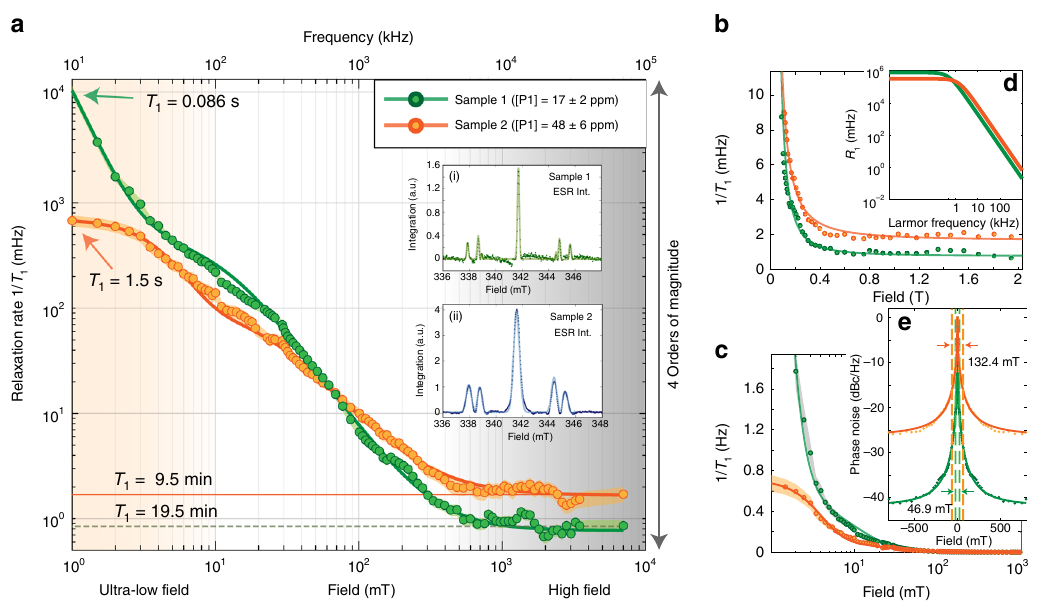
Fig. 3 Hyperpolarized relaxometry at natural abundance 13 C relaxation rate over four decades of fi eld 1 mT-7 T (lower axis) for Samples 1 and 2, probing spin- fl ipping spectral density from 10 kHz to 75 MHz (upper axis). a Relaxation rate on a logarithmic scale, showing steep fi eld dependence that spans four orders of magnitude in T 1 , falling to sub-second lifetimes at ultralow fi elds below B ð 2 Þ K , and saturating to lifetimes >10 min. beyond B ð 1 Þ K . Orange and green data correspond to CVD samples with different concentration of P1 centers 29 (legend). Solid lines are fi ts to a combination of two Tsallian functions. Shaded regions represent error bounds originating from our accelerated data collection strategy (see Supplementary Note 3C). Insets: X-band ESR spectra. b High fi eld behavior shows saturating knee fi eld B ð 1 Þ K occurs at higher fi eld for Sample 2. c Low fi eld behavior, where intriguingly Sample 2 with a higher P1 concentration has a lower relaxation rate. d Calculated relaxation rate R 1 ð ω L Þ arising from the coupling of the 13 C spins with the interacting P1 reservoir for the case of 17 ppm (green) and 48 ppm (orange) electron concentrations, showing qualitative agreement with the experimental data from Samples 1 and 2. e Comparing effective phase noise S p ð ω Þ for the two samples on a semi-log scale. For clarity, data are mirrored on the X -axis and phase noise normalized against relaxation rates at ω 0 = 1 mT. Solid lines are fi ts to Tsallian functions. Dashed vertical lines indicate the theoretical widths obtained from the the respective estimates of 2 d ee h i , 46.7 mT, and 131.89 mT, matching very closely the experiments.